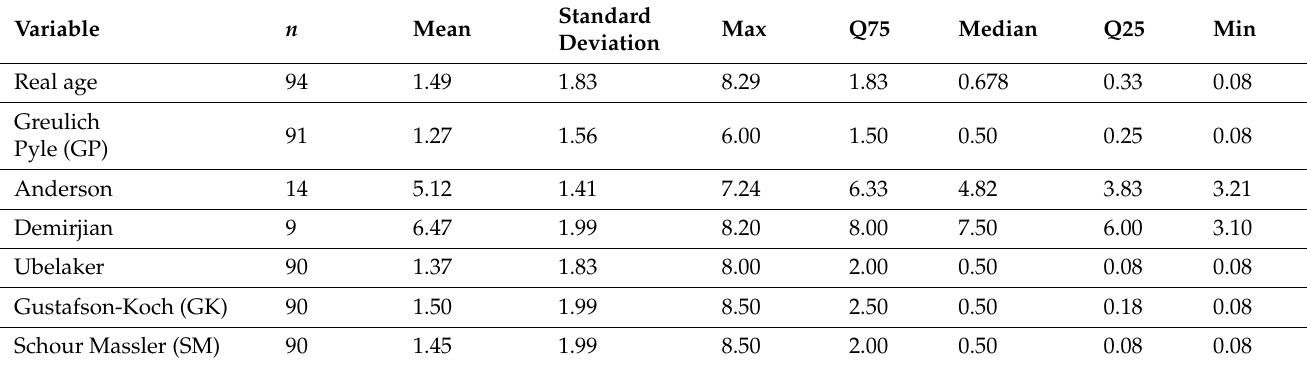
Table 1. Descriptive statistics of real age and age estimation for each